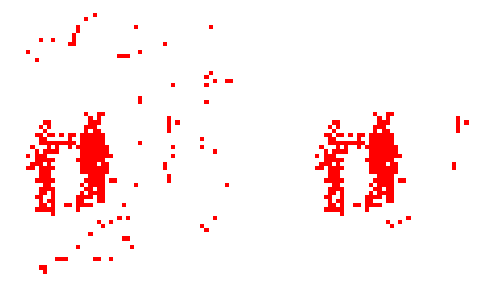
Figure 5. Foreground detection results (by red) in the Courtyard scene, displayed in range image